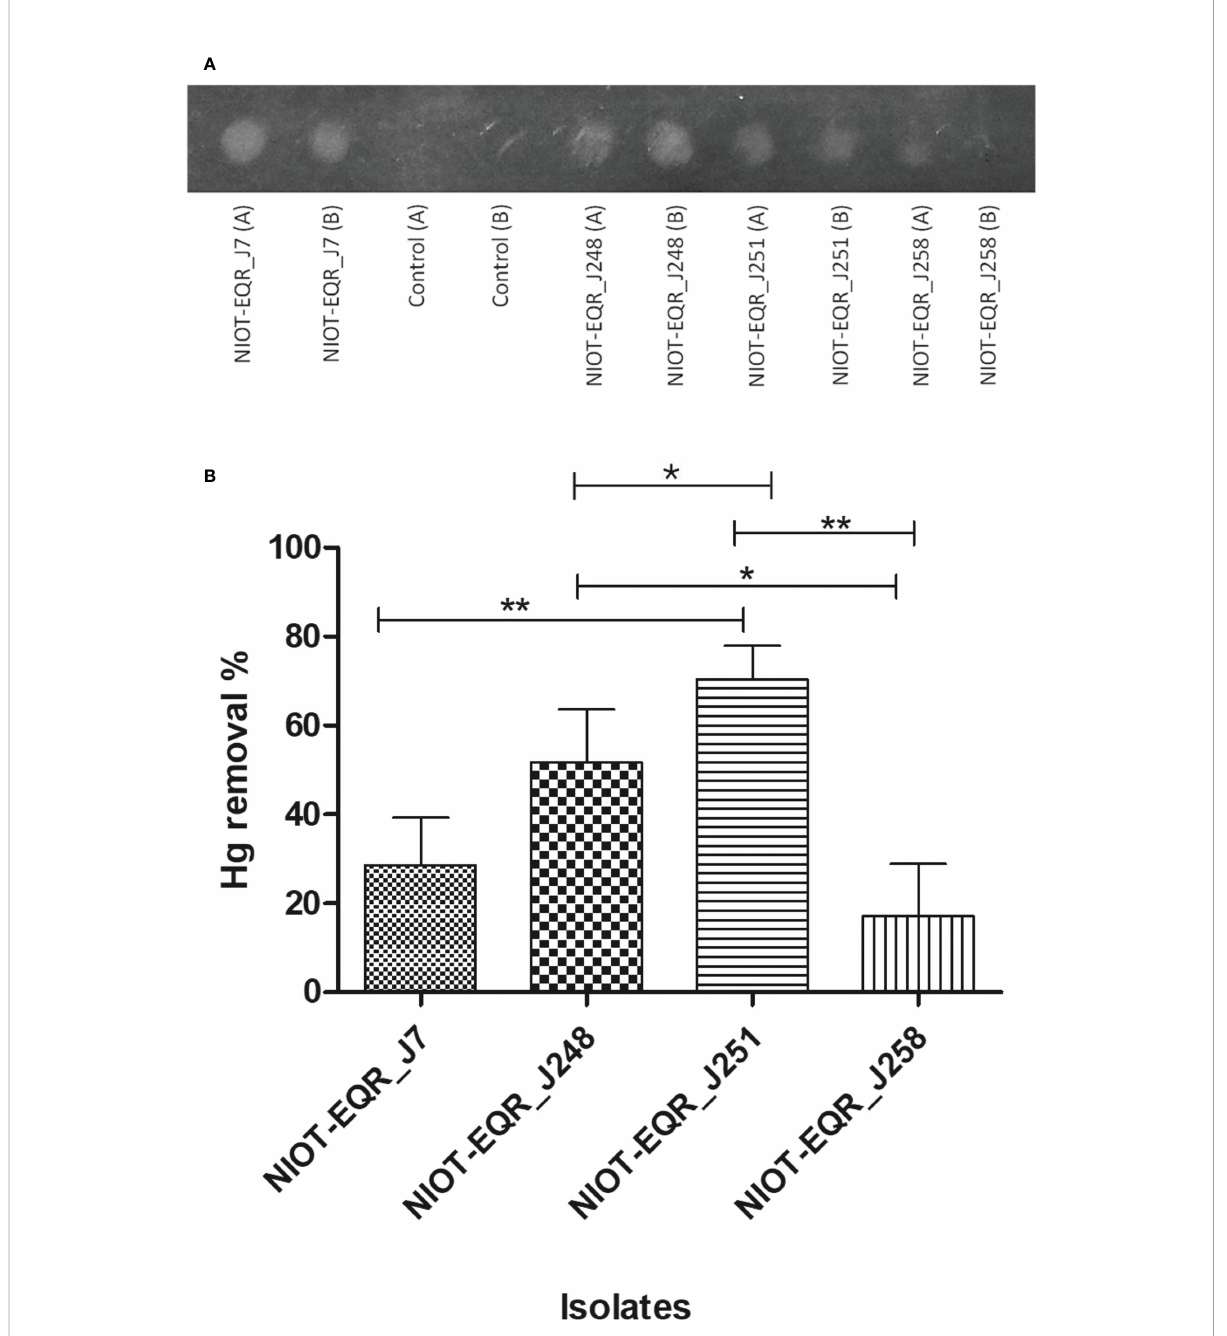
FIGURE 4 (A) Bacterial volatilization of HgCl 2 was con fi rmed by the X-ray fi lm method. (A) Represents the Hg volatilization in the presence of 50 mg/L whereas (B) corresponds to the 100 mg/L of Hg as HgCl 2 . (B) Hg depletion potential of the marine cultures in the presence of 50 mg/L of Hg as HgCl 2 . Bars with an asterisk (* and **) indicate noteworthy differences among the cultures in the level of p< 0.05 and p< 0.01, respectively. Results are represented as mean ± SD